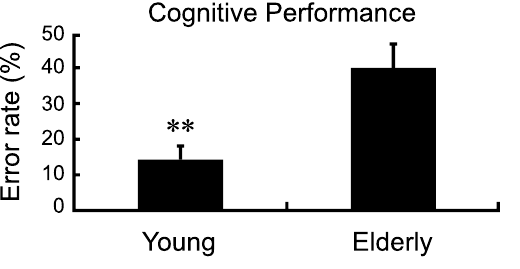
Figure 5. Cognitive performance in young and older adults. Cognitive performance was determined by error rate (numbers of errors/total number of questions*100%). Error bars represent 6 1 SEM. ** p , 0.01.